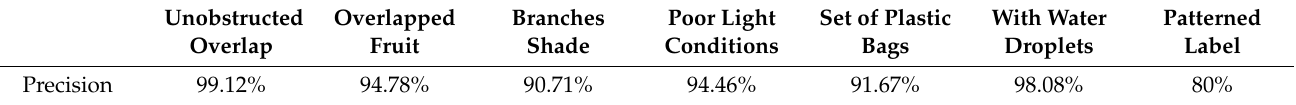
Table 4. The accuracy of the test results was measured by the method. Unobstructed